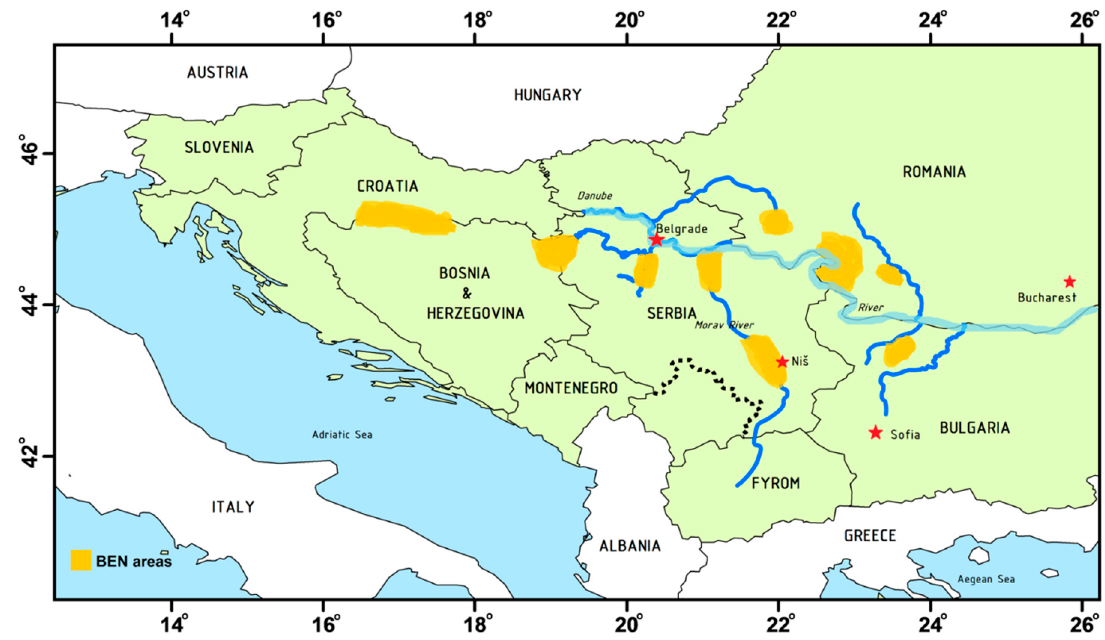
Figure 2. Map showing the geographic distribution of endemic nephropathy in rural farming villages located near tributaries of the Danube River in countries of the Balkan Peninsula.